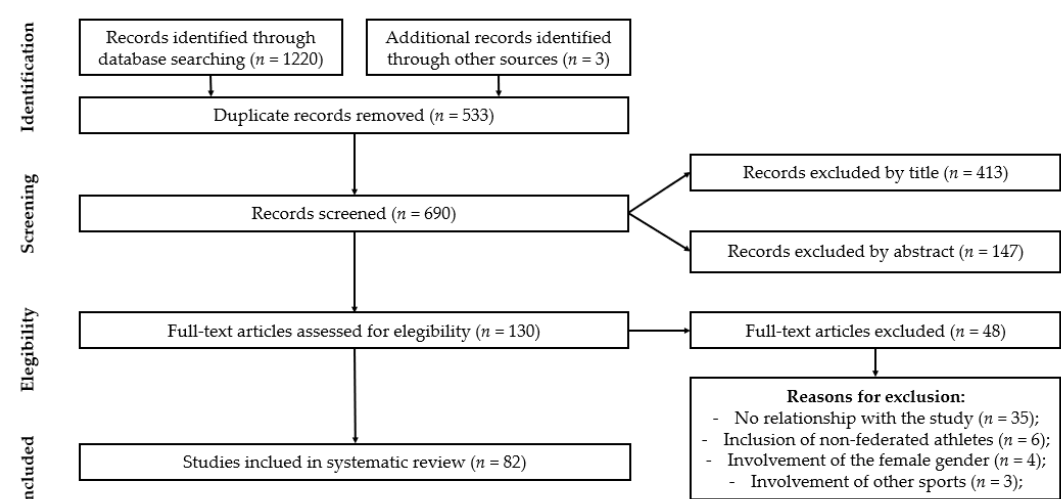
Figure 1. Article selection process flowchart.